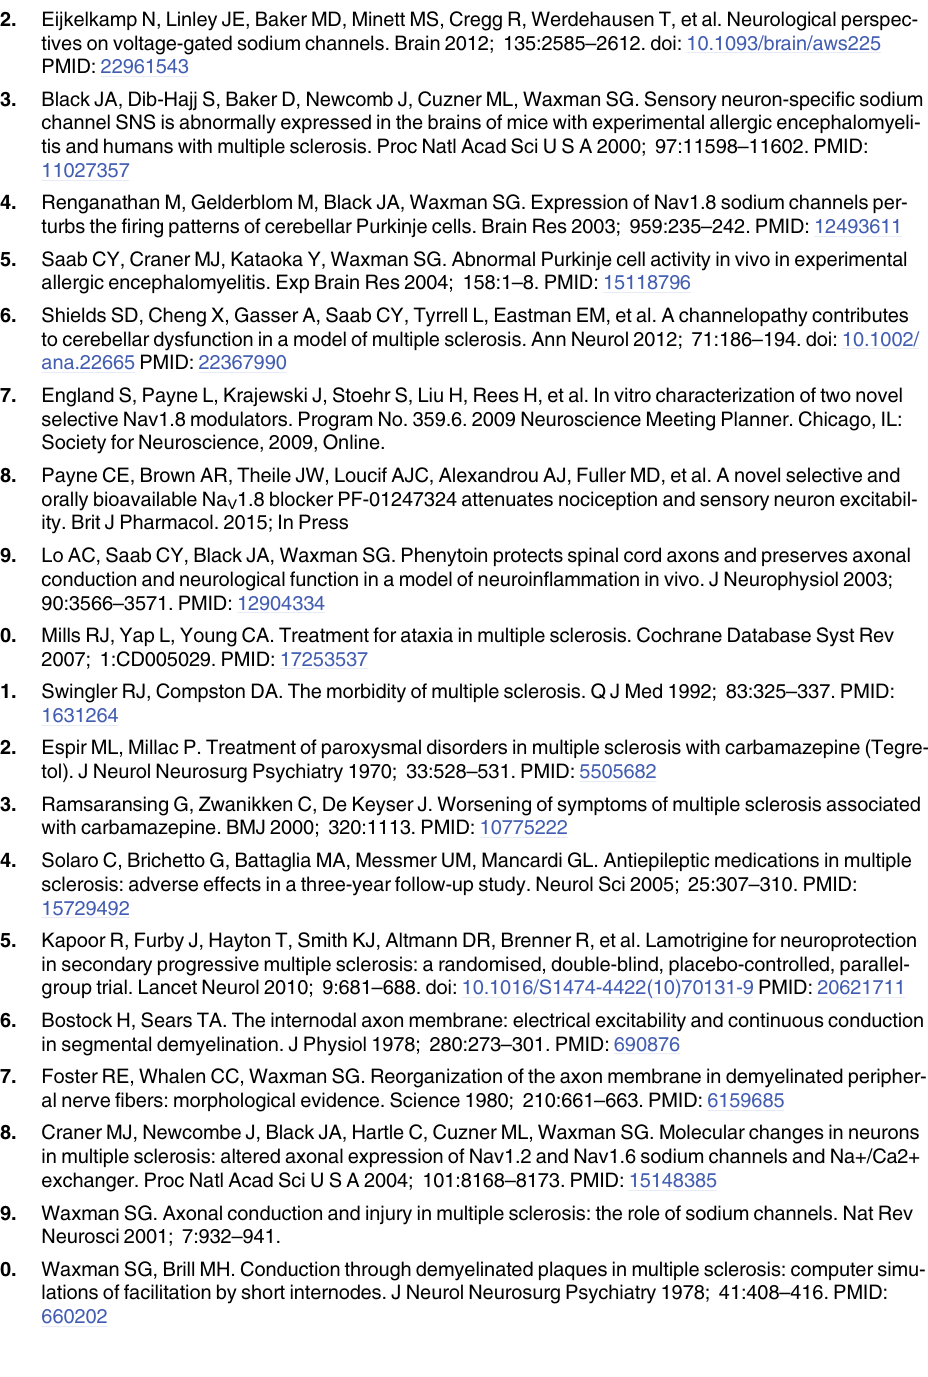
PLOS ONE | DOI:10.1371/journal.pone.0119067 March 6,